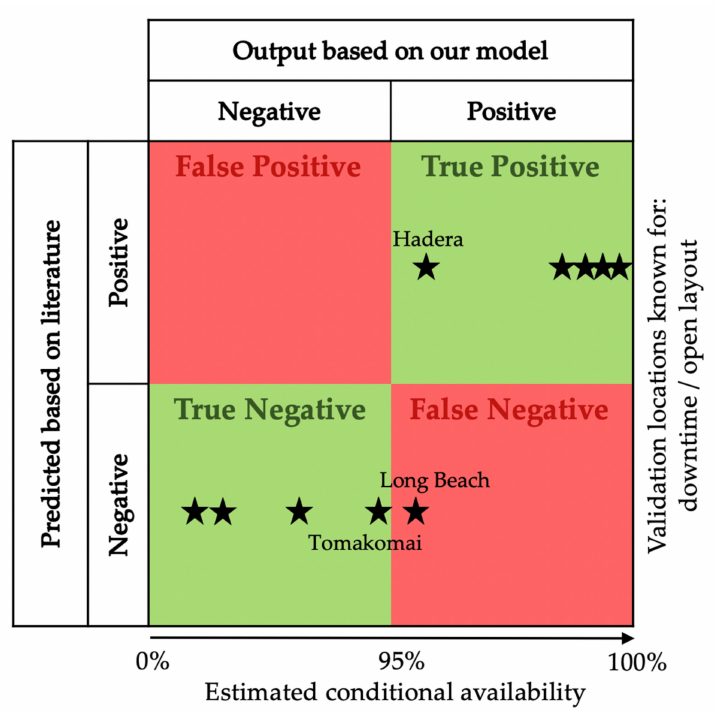
Figure 3. Confusion matrix classification: True or False Positive (or Negative). A True Positive (TP) is an outcome where the model correctly predicts the positive class. Similarly, a True Negative (TN) is an outcome where the model correctly predicts the negative class. A False Positive (FP) is an outcome where the model incorrectly predicts the positive class. And a False Negative (FN) is an outcome where the model incorrectly predicts the negative class. The stars correspond to the 10 (existing) port